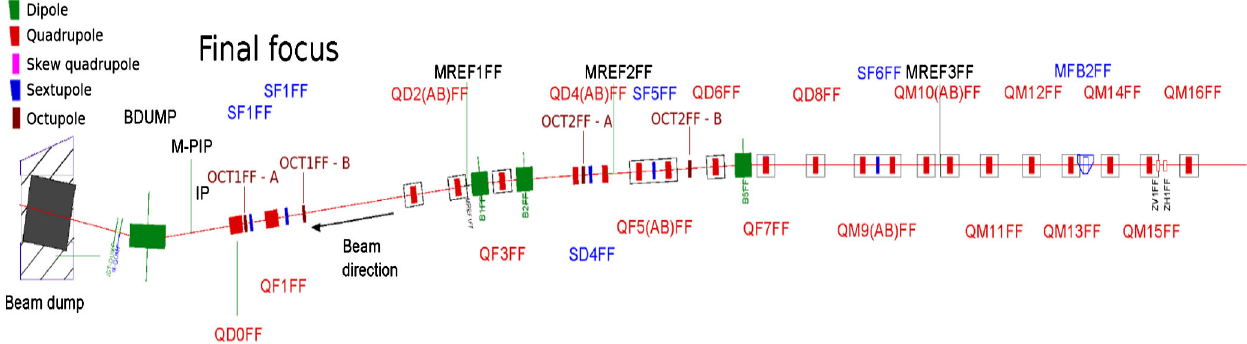
FIG. 7. Layout of ATF2 final focus line, with the two octupoles locations under